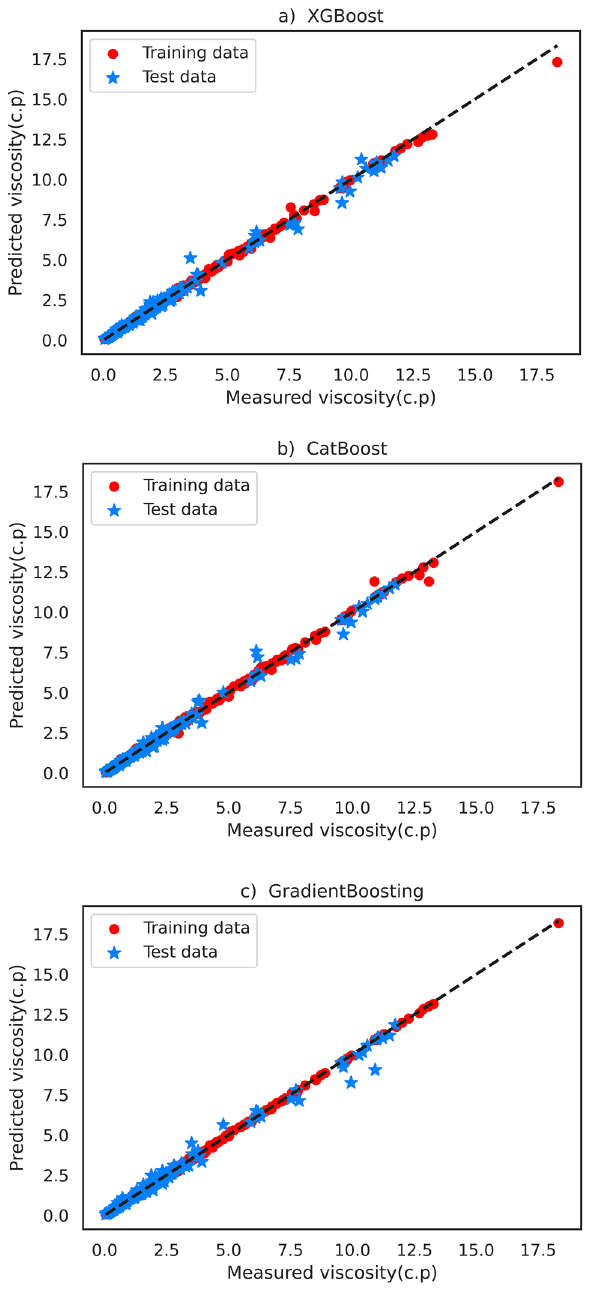
Figure 3. Cross plots of the implemented models: ( a ) XGBoost, ( b ) CatBoost, and ( c ) GradientBoosting.